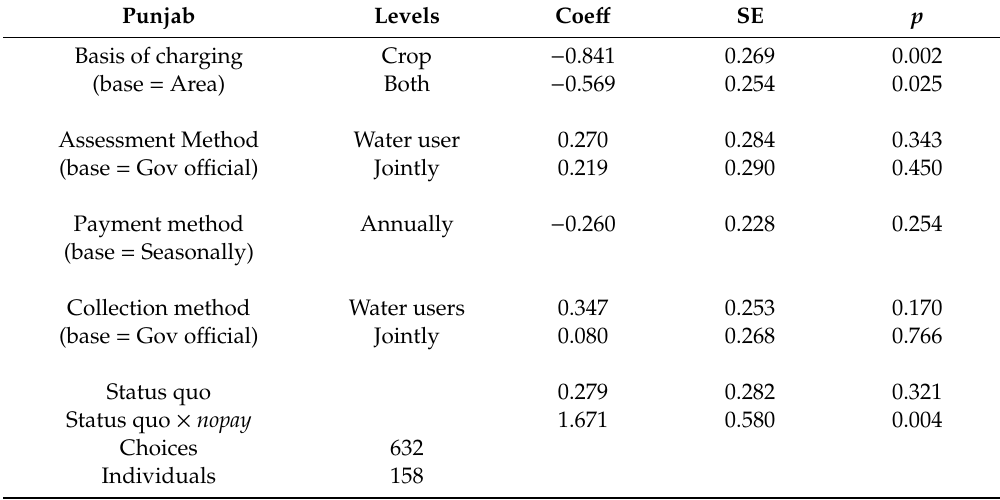
Table 8. Conditional logit estimates for preferences for irrigation payment systems: Punjab.